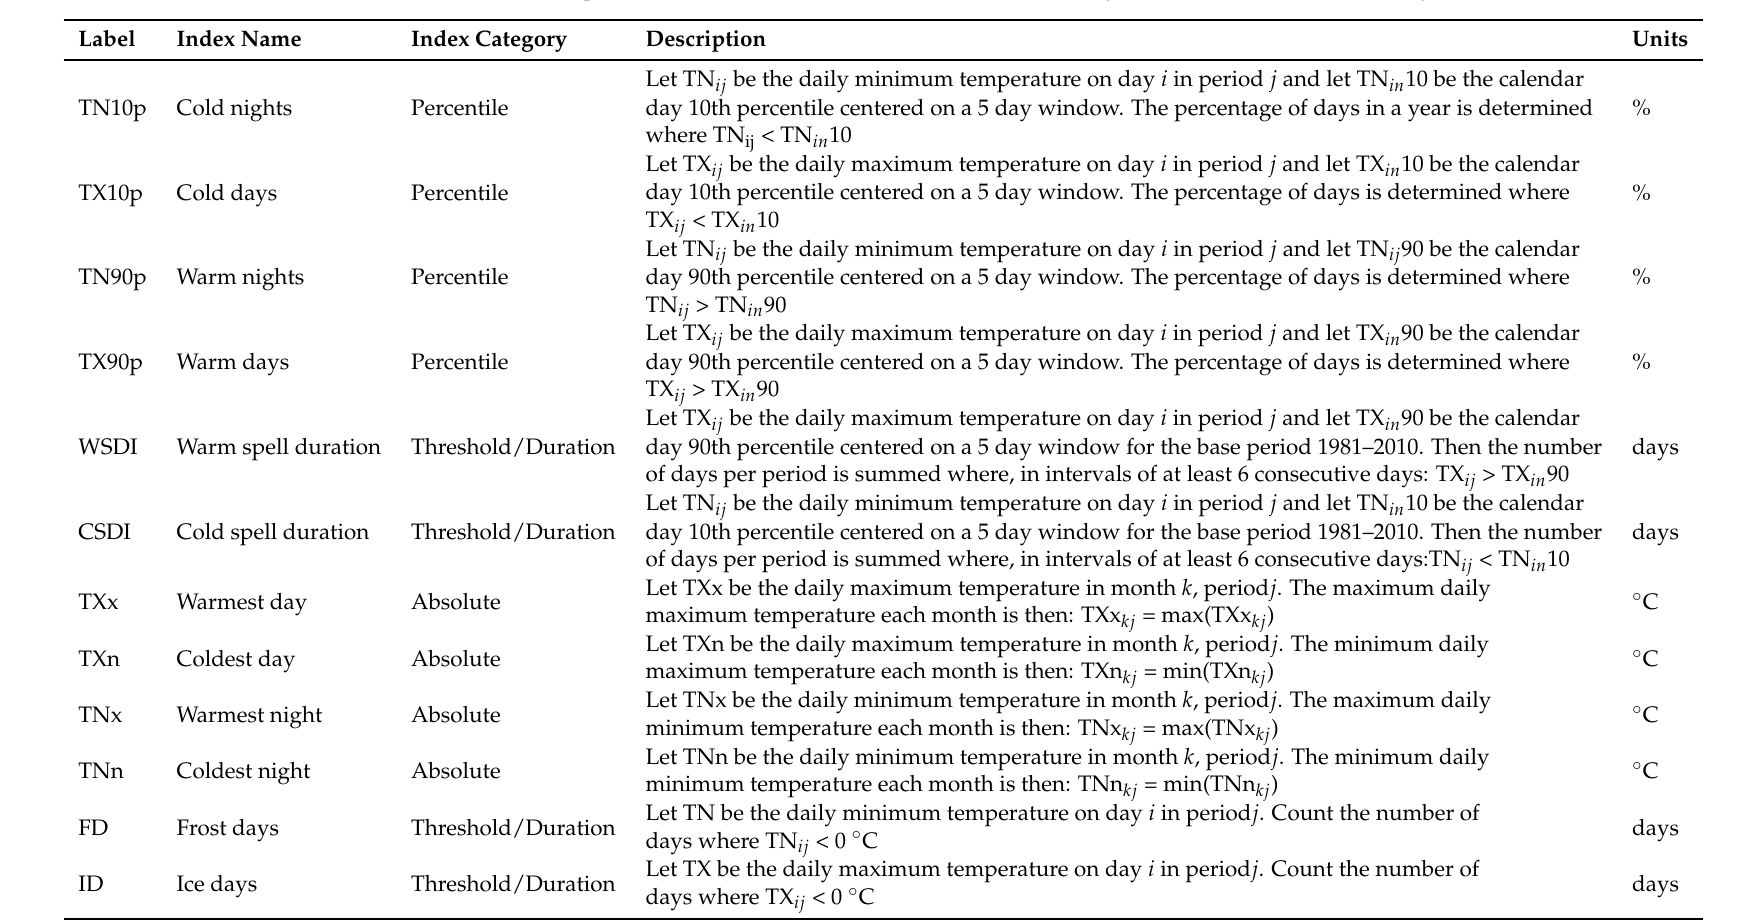
Table 2. Set of the 12, temperature-based, indices of extremes, recommended by the ETCCDI, used in this